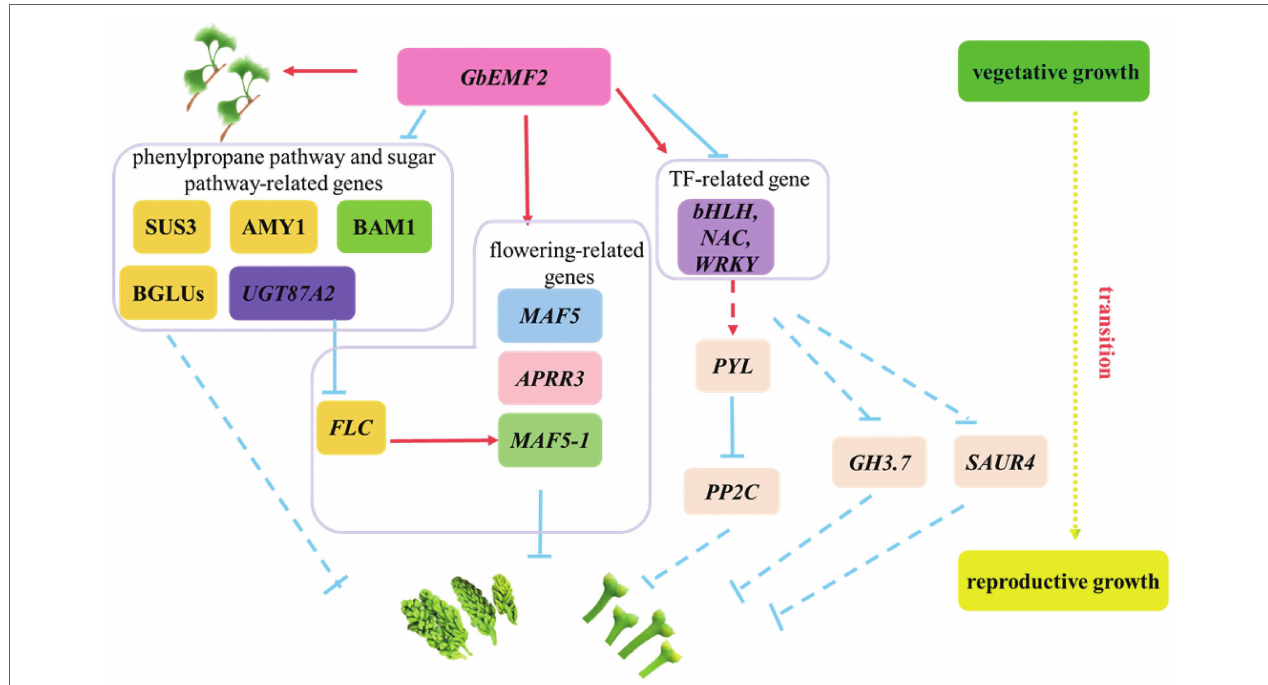
FIGURE 9 | A hypothetical model for the GbEMF2 regulated other genes controlling flowering in G. biloba . Red arrow represents promoting. The inhibition is represented by the blue inverted T line. The solid lines represent by verified in the literature, and the dashed lines represent